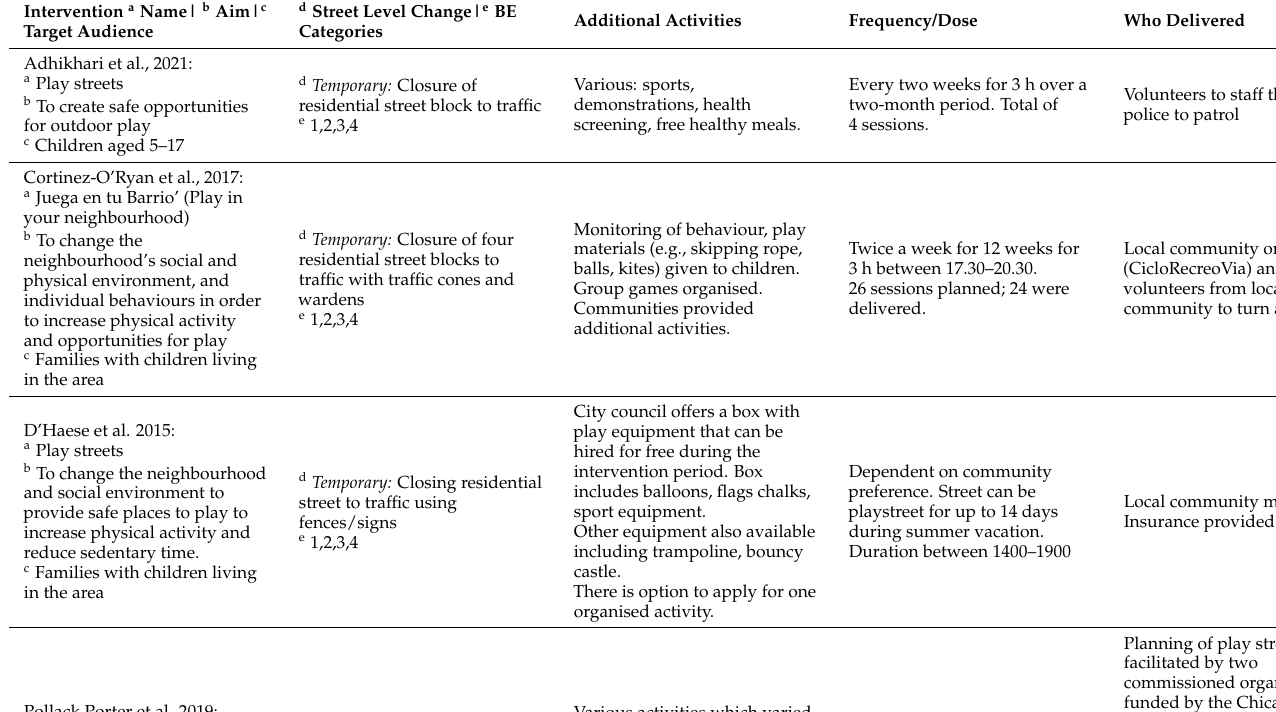
Table 2. Summary of key street closure interventions